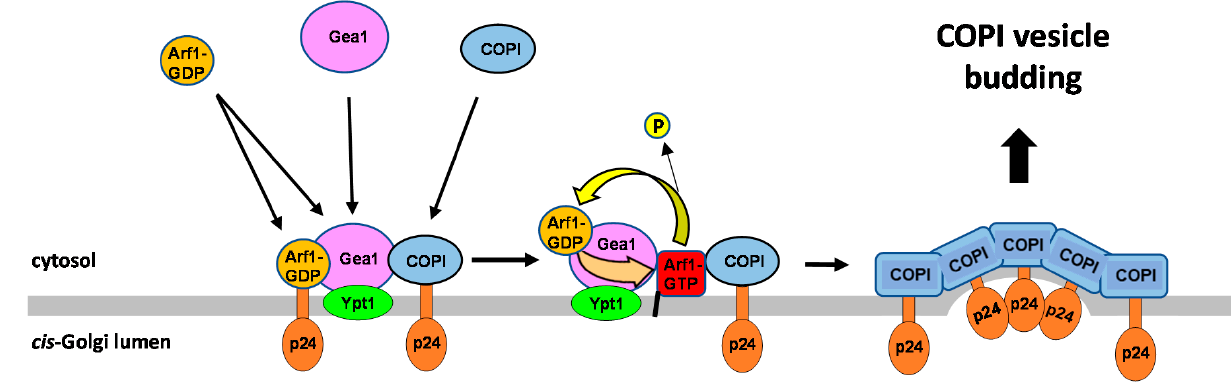
Figure 7. Schematic representation of the proposed role of the p24 complex in programming Arf1 activation by Gea1 for selective COPI coat assembly. COPI can be initially recruited by the p24 complex, a major retrograde cargo of COPI vesicles, to the cis -Golgi membrane independently of Arf1 activation. There, the p24 complex and COPI form a transient complex with the ArfGEF Gea1 through direct binding to COPI. Gea1 is separately recruited by the Rab GTPase Ypt1 to the cis -Golgi membrane lacking anionic lipids. The p24 complex has been also proposed to facilitate the recruitment of the inactive form of Arf1 (Arf1-GDP). Arf1-GDP could be also recruited by Gea1 as its substrate. The local formation of this transient complex ensures that Arf1 activation by Gea1 occurs in the proximity of COPI, which leads to the COPI coat assembly by the generated Arf1-GTP and the p24 complex. Arf1-GTP can be deactivated by the specific COPI-associated ArfGTPase Glo3 to initiate a new activation cycle by Gea1. Thus, through this feed-forward mechanism, the p24 complex could contribute to establish COPI vesicle budding sites by facilitating the local encounter of COPI, Gea1 and